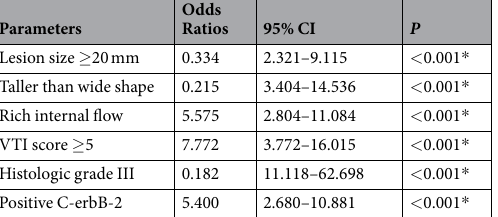
Table 3. Univariate analysis in predicting axillary lymph node metastasis. CI confidence interval. * Indicates statistically significant difference.